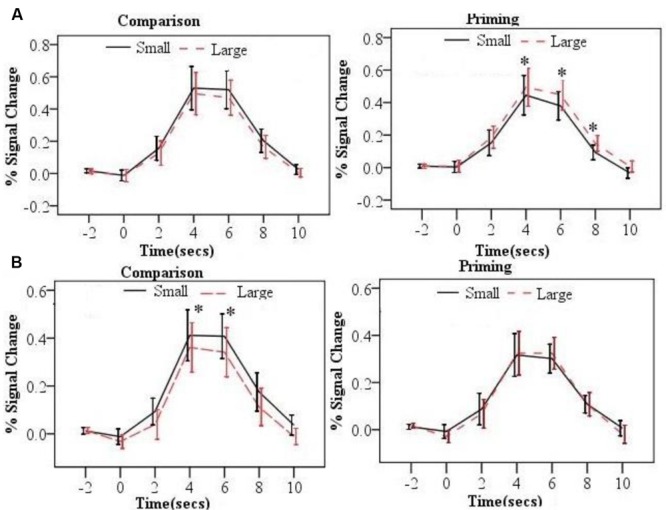
The time courses by distance (small and large) and task (comparison and priming) for the left parietal lobe ROI (A), the right parietal ROI (B). Error bars represent 95% confidence interval (∗p < 0.05).